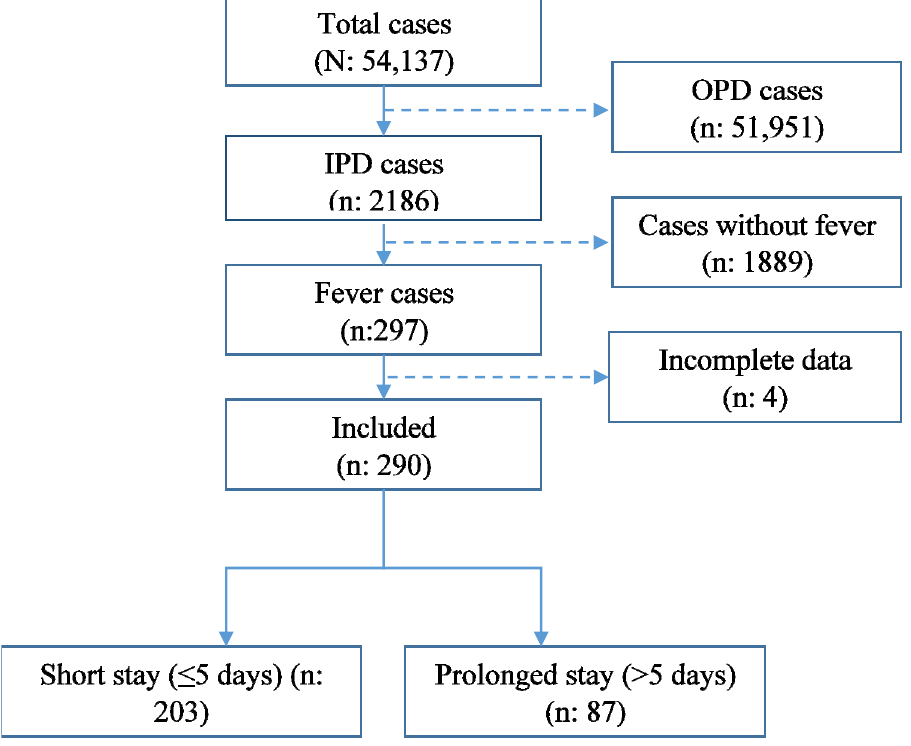
Figure 2. Flowchart on the assessment of hospital records of patients with fever admitted at the Samtse Hospital, Bhutan, 2020. IPD—Inpatient Department; OPD—Outpatient Department.